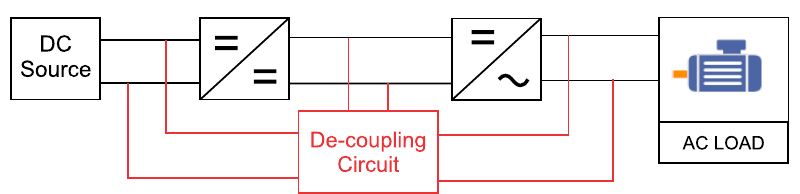
Figure 2. Series interfacing of APDC.